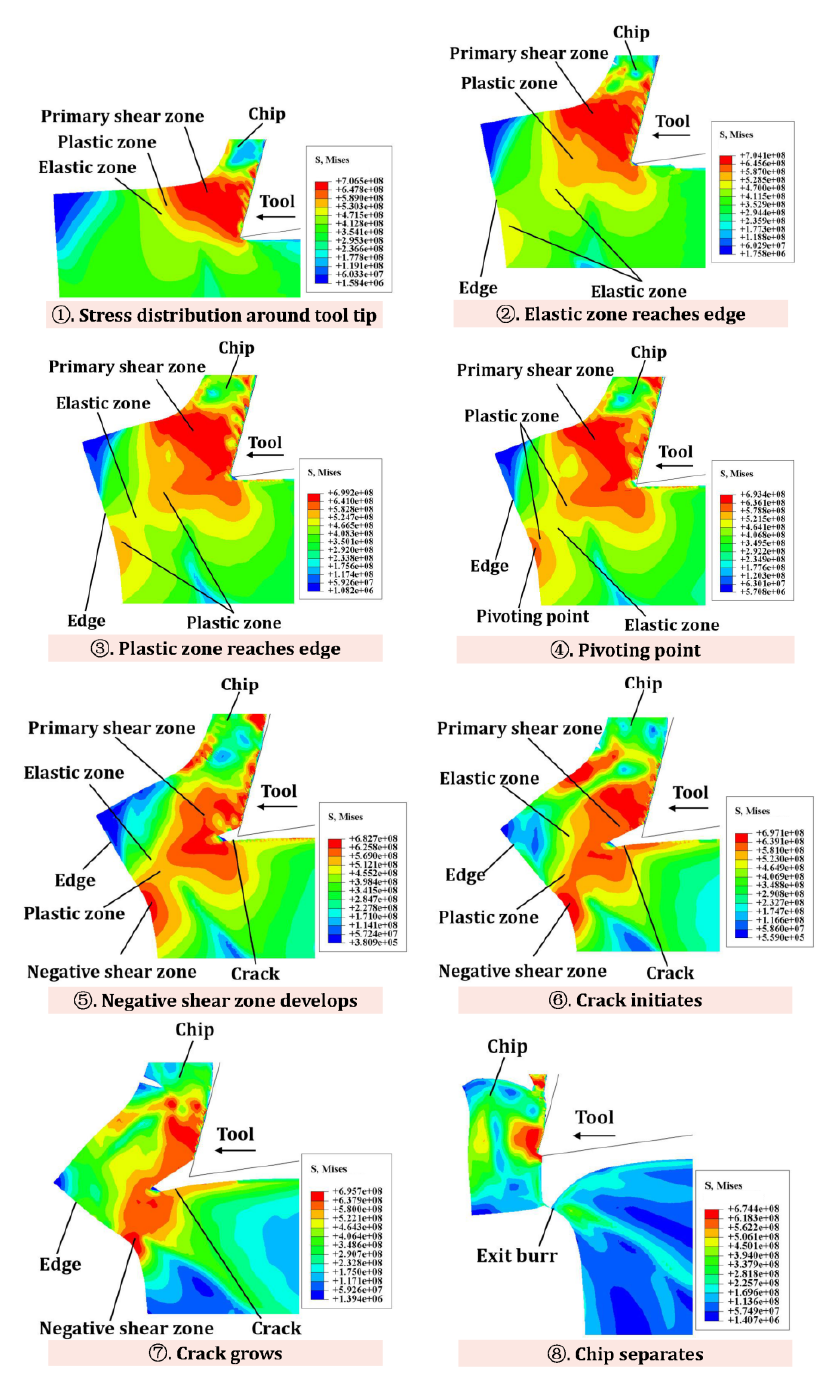
Figure 5. Schematic diagram of stress flow at the workpiece edge.